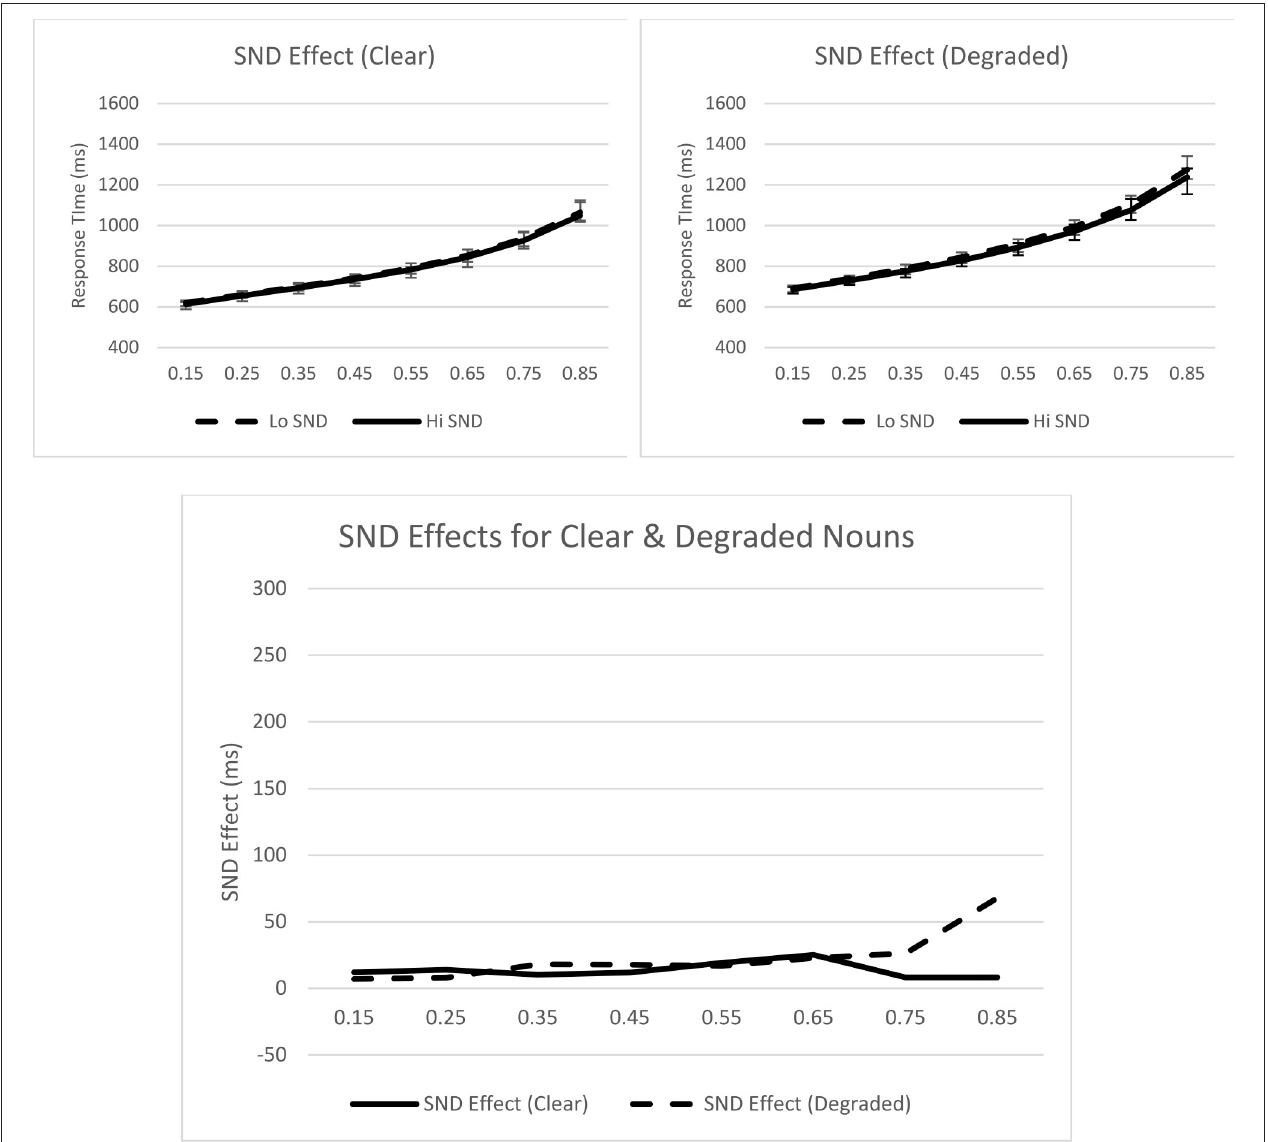
FIGURE 3 | Syntactic classification performance as a function of semantic neighborhood density and quantiles for clear (top left panel) and degraded (top right panel) words. Empirical quantiles are represented by error bars, whereas fitted ex-Gaussian quantiles are represented by lines. The bottom panel shows semantic neighborhood density effects as a function of stimulus quality. SND, semantic neighborhood